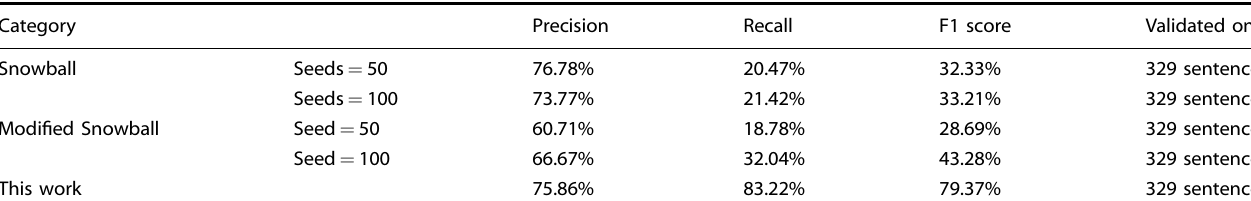
Table 3. Precision, recall, and F1 score of the “ Snowball ” , modi fi ed “ Snowball ” algorithm and method employed in this work.